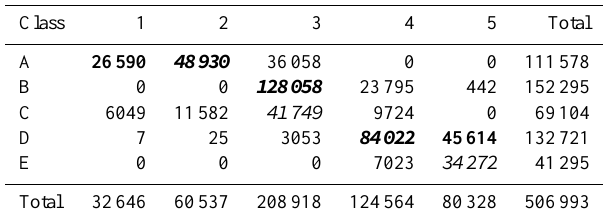
Table 2. Cross-tabulation of grid cells assigned to the K¨oppen- Geiger (A to E) and MRT climate classifications (1 to 5) at the 5 class level. Italicized (bold) entries indicate the largest value in a given row